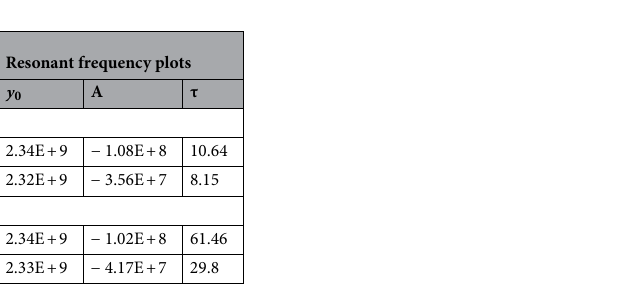
Table 1. Curve fitting results on data presented in Figs. 10 and 11 ( Curve Fit = y 0 + Ae x /τ ) .